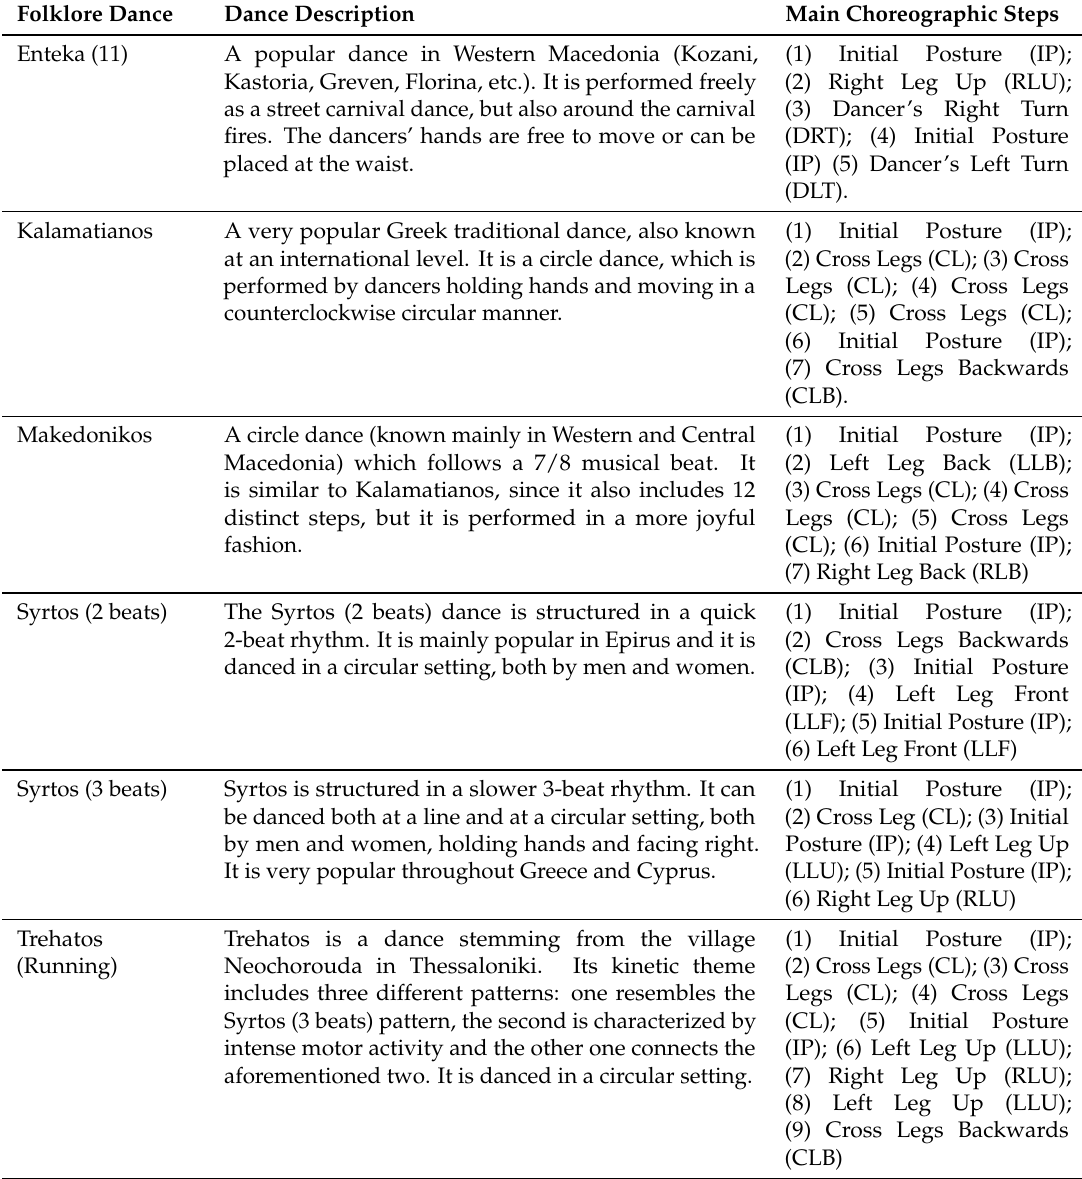
Table 1. Greek folklore dances and the main choreographic steps.